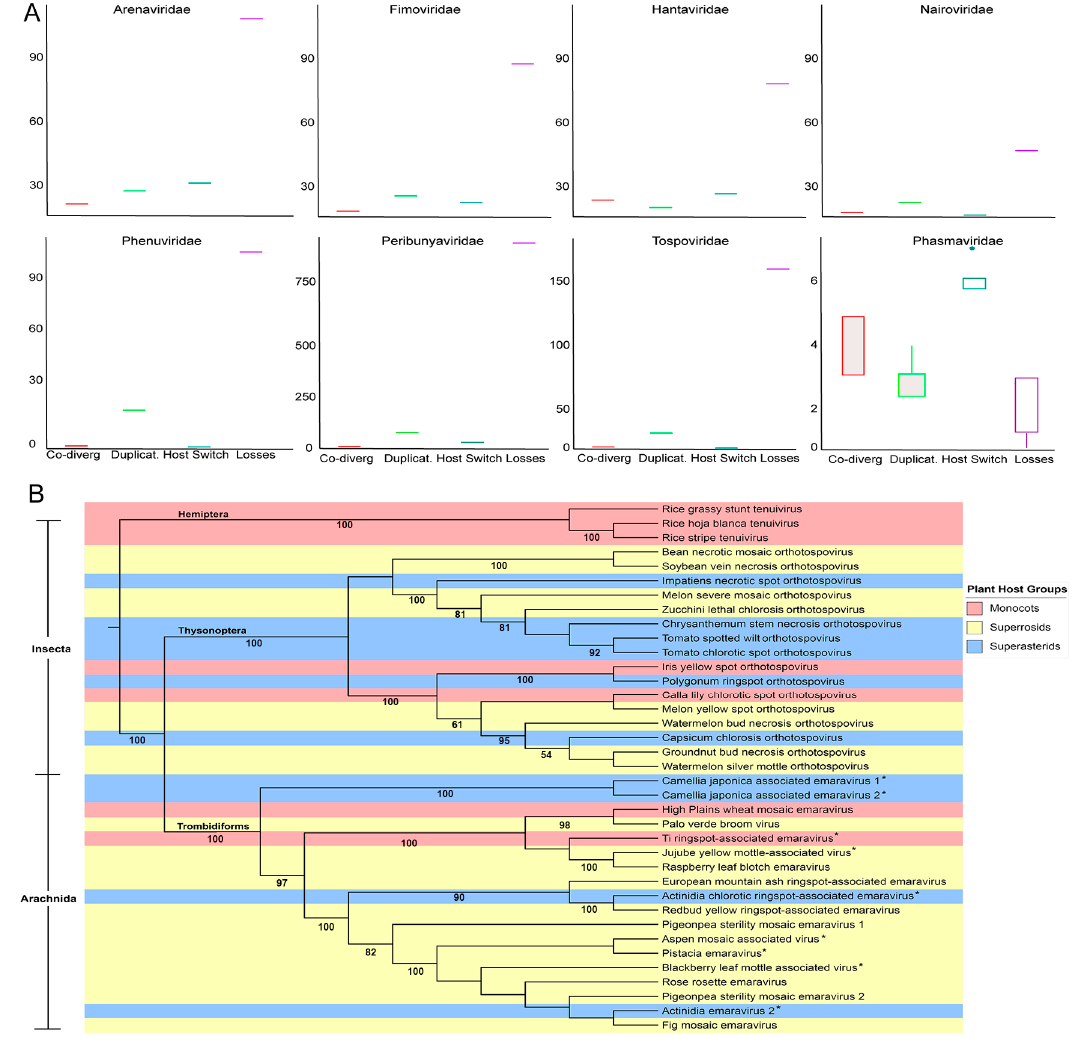
Figure 8. Estimation of co-phylogenetic events of the nucleic acid sequence of plant-infecting virus families within Bunyavirales . ( A ). The cophylogeny relationship is based on the RdRp sequences and analyzed using Jane ver. 4.0.1. ( B ). A neighbor joining tree generated using concatenated genomic segments containing RdRp, NC, GP, and MP. Color was used to identify host plant taxonomies and insect vector taxonomy is provided along the branches. Bootstrap values are